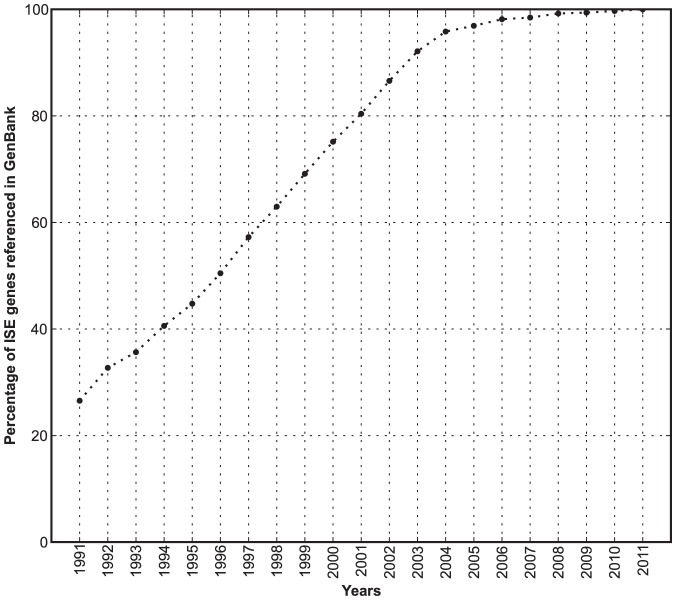
Year of discovery of genes.The x-axis represents the timeline. The line represents the perecentage of ISE genes whose mRNA or protein have been referenced into GenBank.